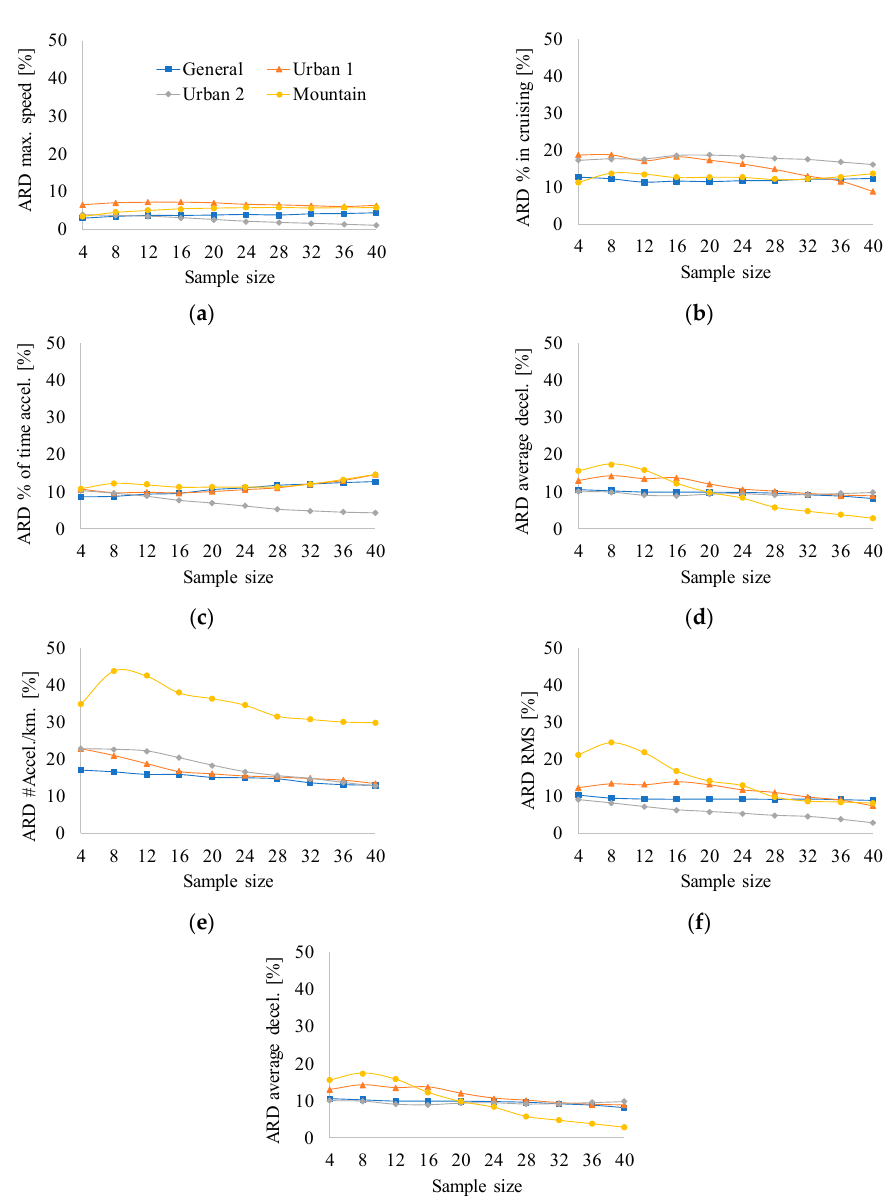
Figure A1. Average relative differences (ARD) of characteristic parameters (CPs) commonly used to describe driving cycles (DC) as a function of the number of trips sampled and the type of regions used in this study. ( a ) maximum speed; ( b ) percentage of time in cruising; ( c ) percentage of time with positive acceleration; ( d ) average deceleration; ( e ) number of accelerations per kilometer; ( f ) root mean square and ( g ) percentage of time in deceleration.